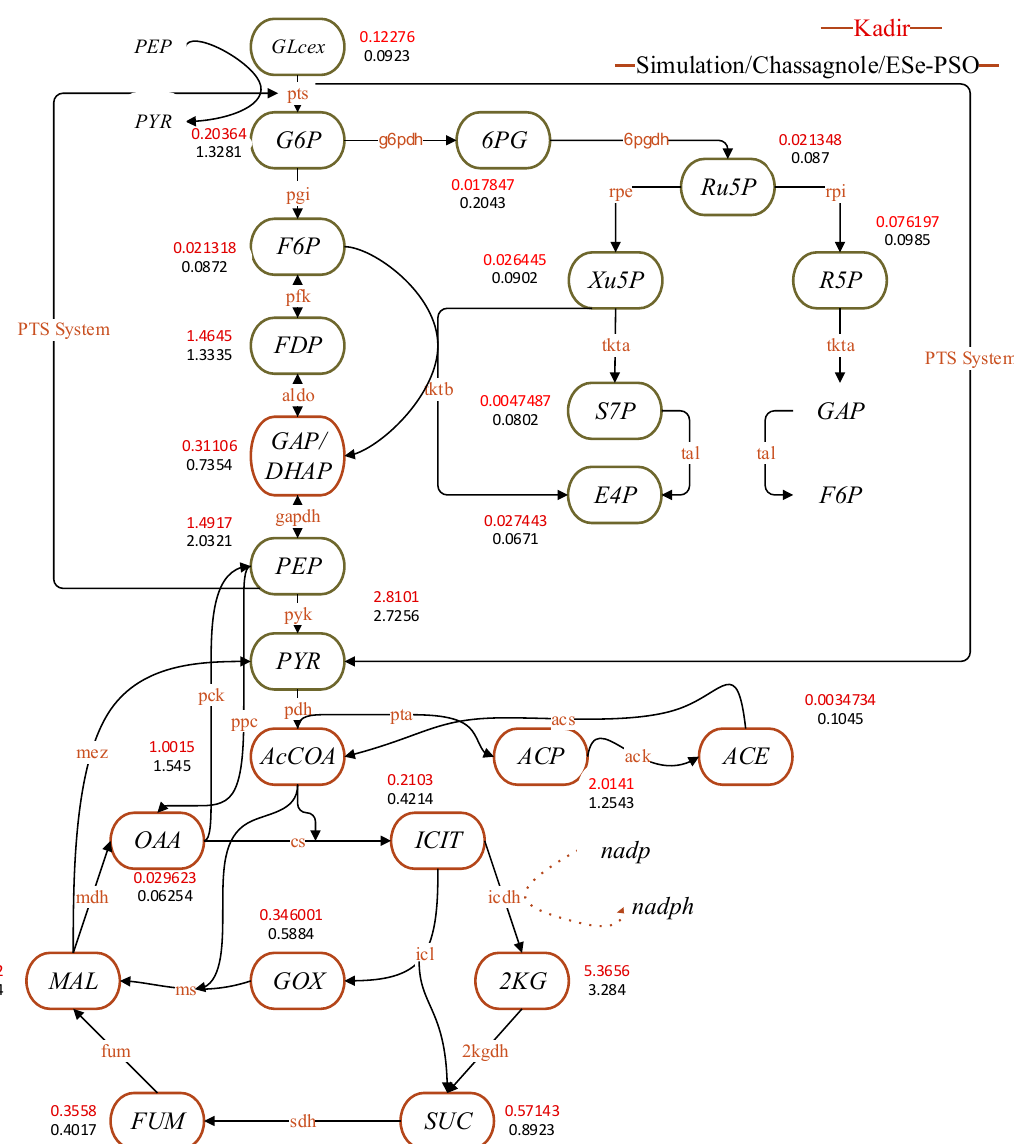
Figure 2. Model simulation based on real experimental data.